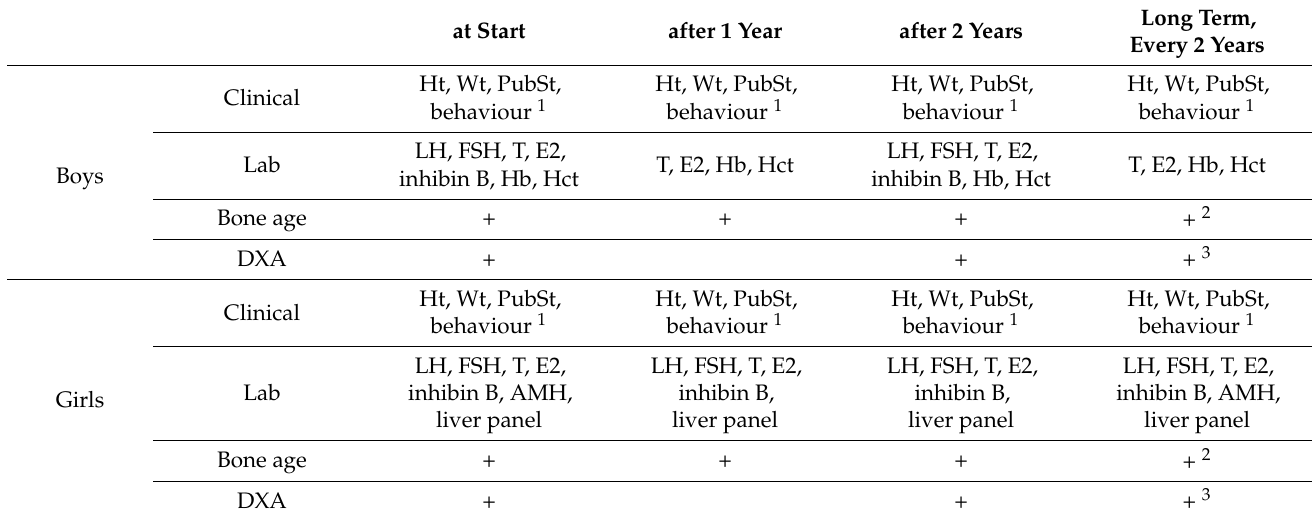
Table 2. Examination strategy for sex steroid supplementation in PWS patients at our